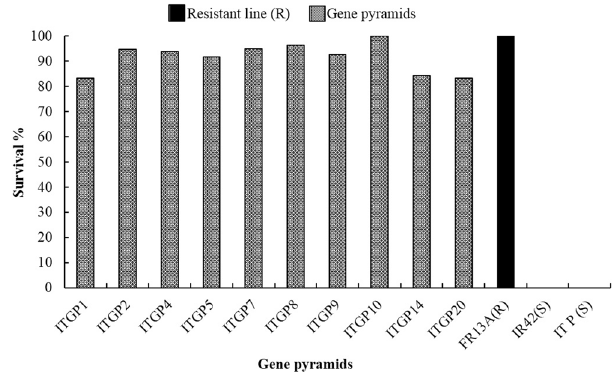
Figure 6. Survival rates of different after submergence stress and desubmergence.